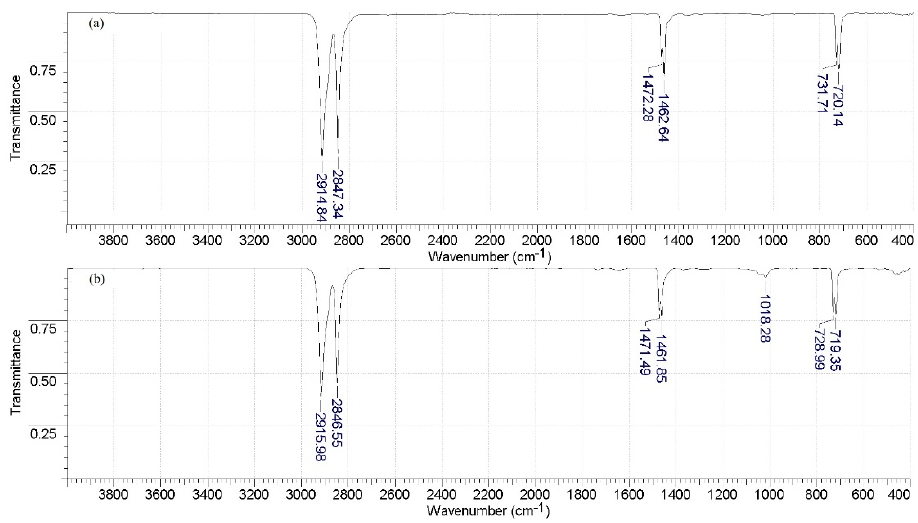
Figure 9. IR spectra of the MA-40L anion-exchange membrane before use in the electrodialyzer ( a ) and after use in the electrodialyzer ( b ).